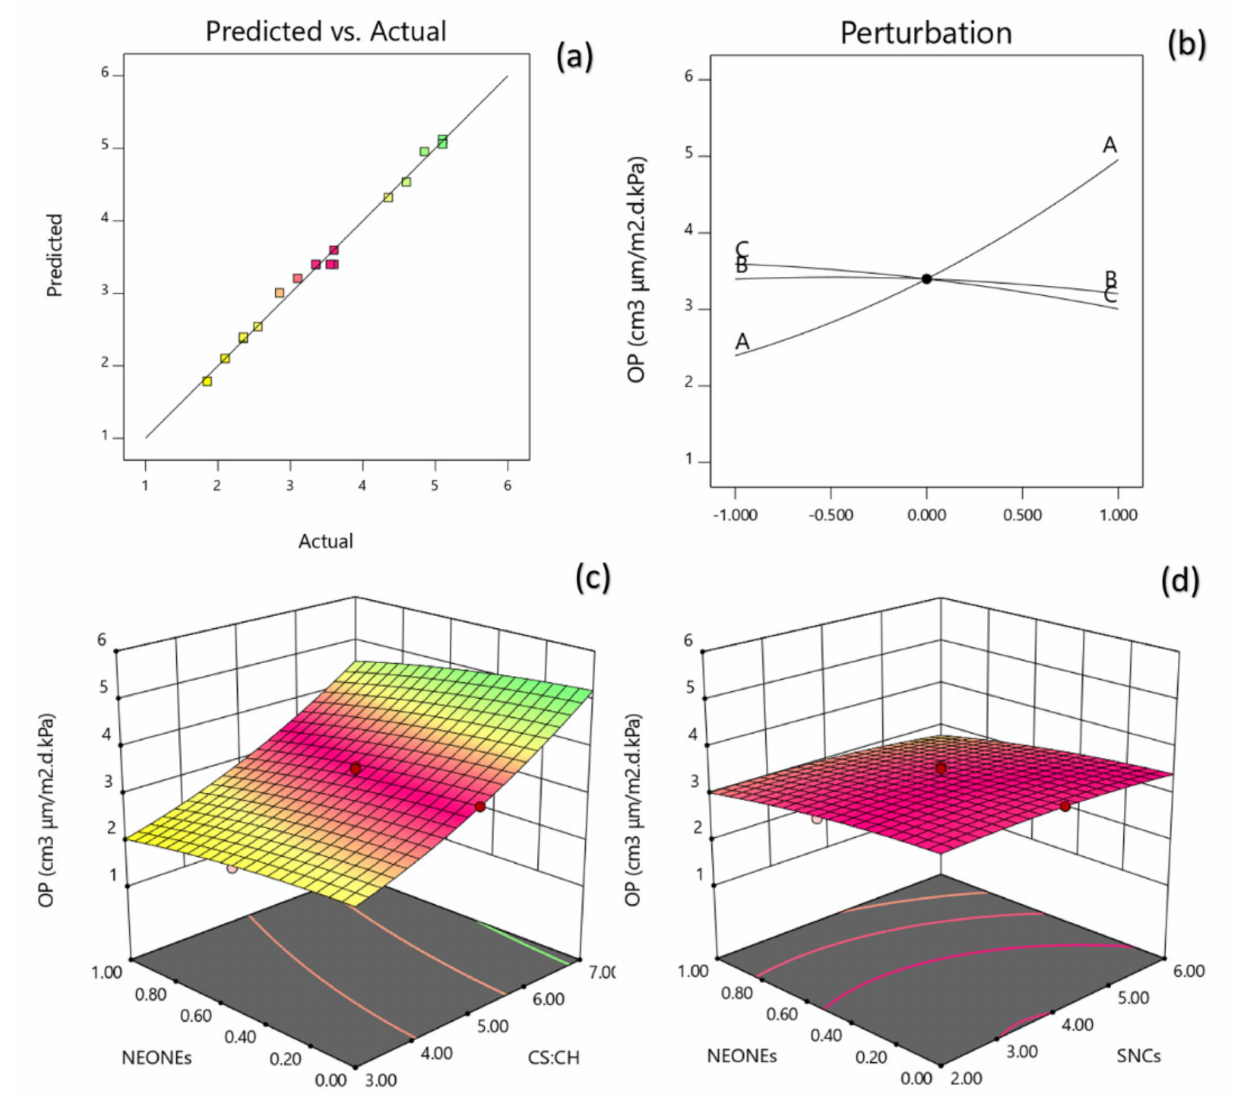
Figure 11. Counter and perturbation graphs ( a , b ), the interaction between CS:CH and SNCs concentration and also interaction between SNCs and NEONEs concentration on oxygen permeability (OP) of the produced film ( c , d